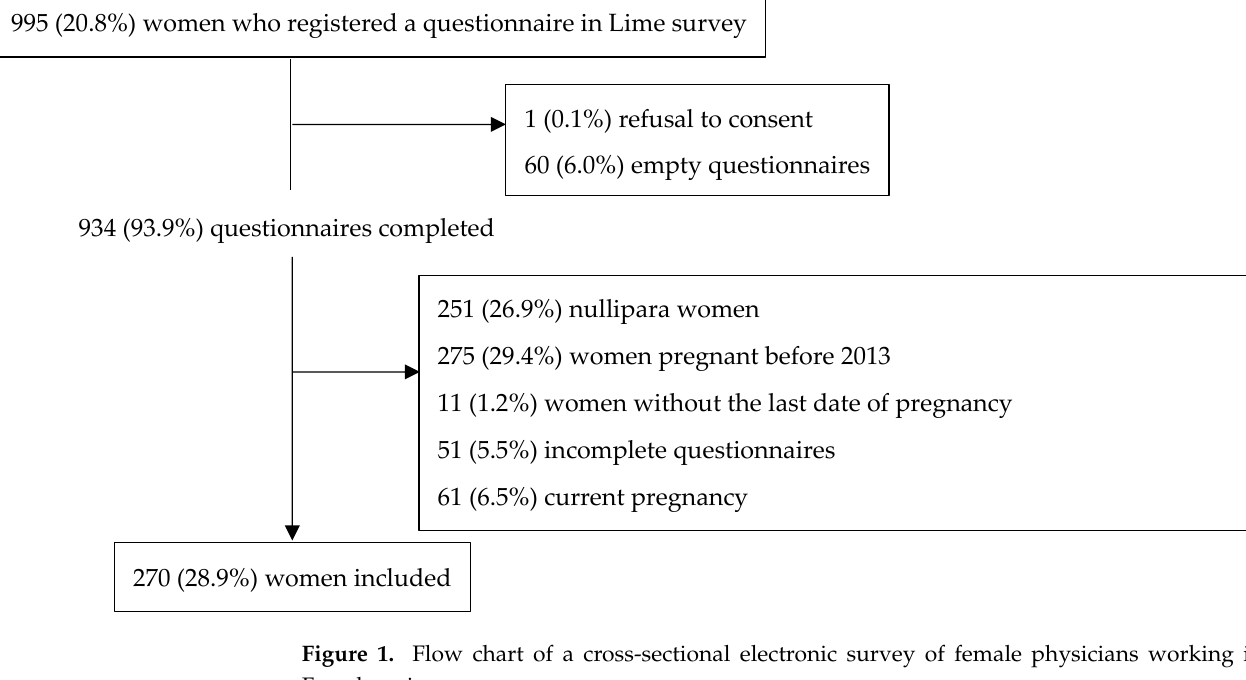
Table 1. Main characteristics of the study population according to the